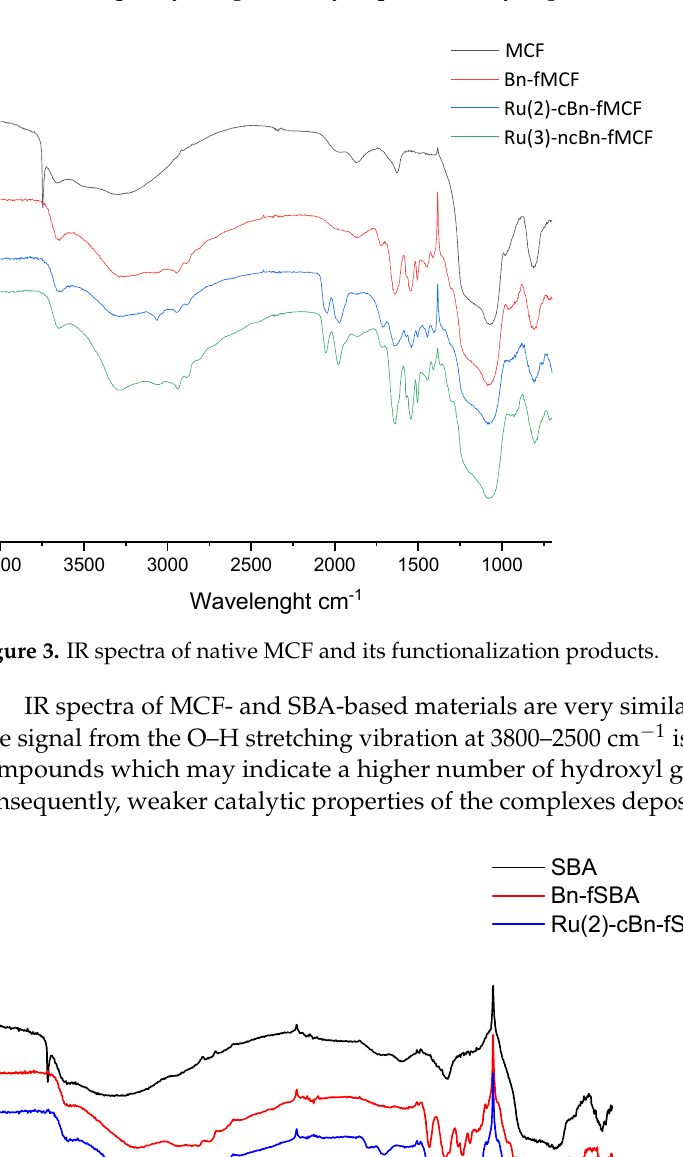
Figure 4. IR spectra of native SBA and its functionalization products.